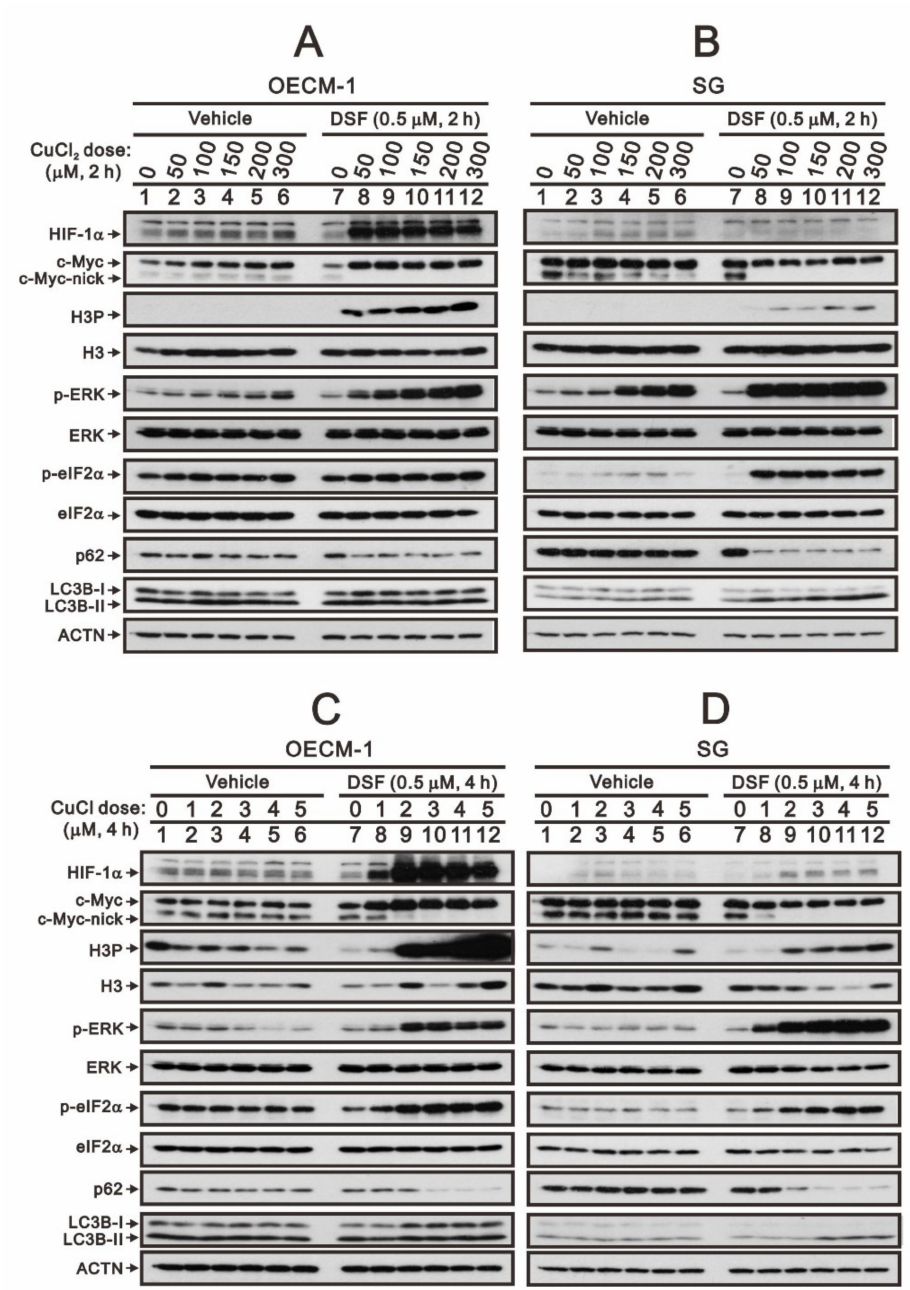
Figure 1. The effects of DSF, copper ions, and DSF/copper complexes on c-Myc and HIF-1 α proteins in OECM-1 and SG cells. OECM-1 ( A , C ) and SG ( B , D ) cells were treated with the indicated concen- trations of copper ions in the absence or presence of DSF for 2 h ( A , B ) or 4 h ( C , D ). The cell lysates were subjected to Western blot analysis using antibodies against the indicated proteins. ACTN was a loading protein control. The results are representative of three independent